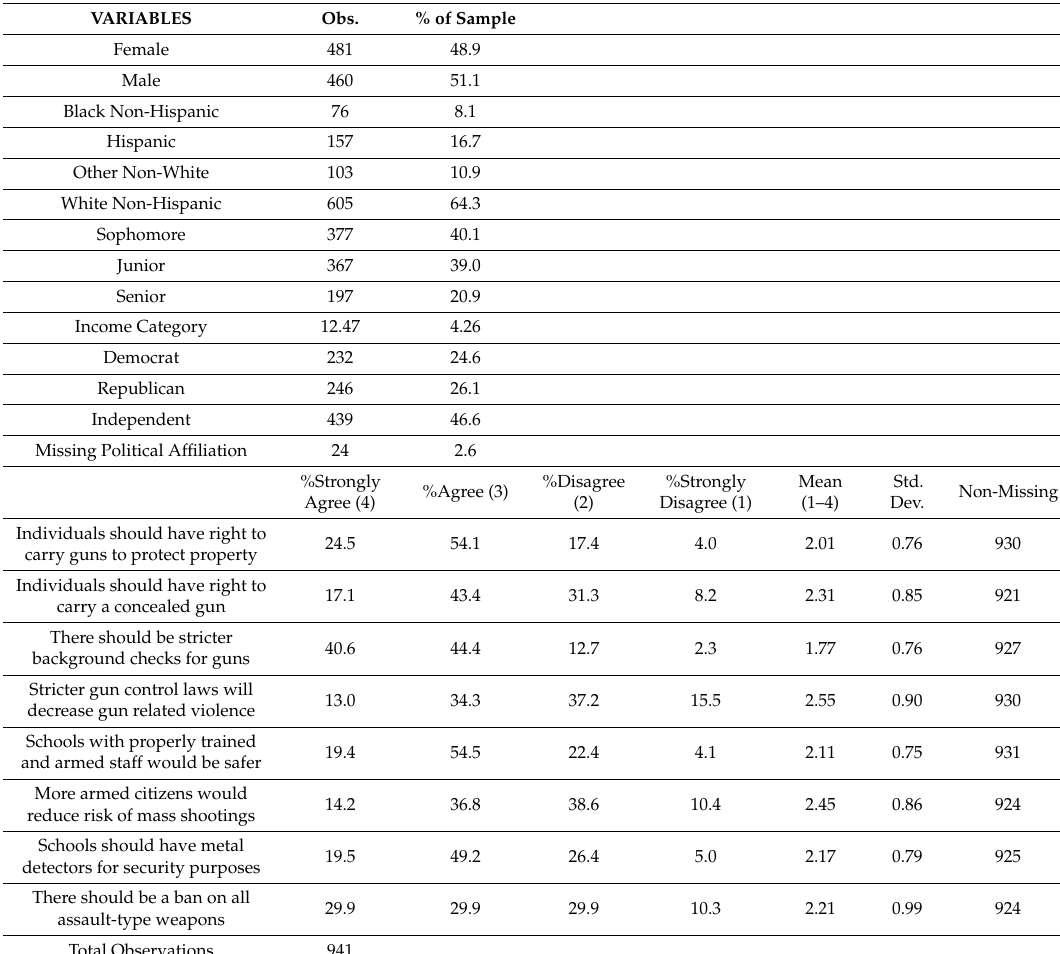
Table 1. Summary